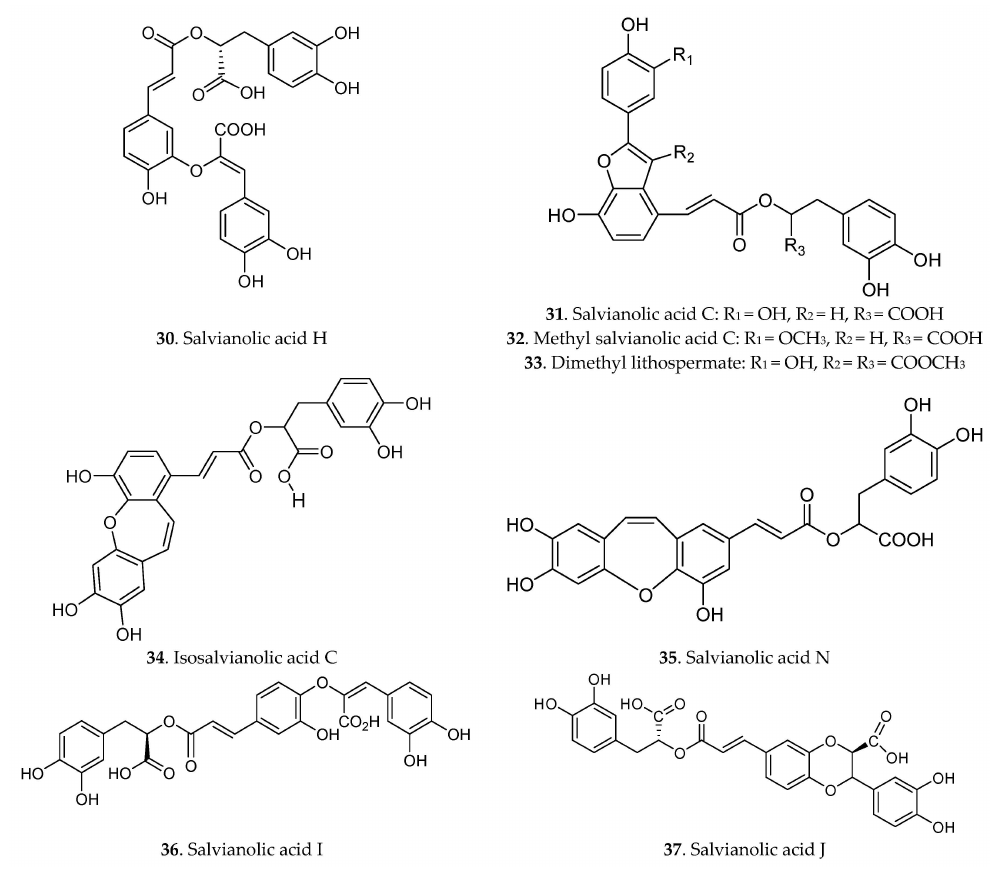
Figure 2. Phenolic acids in Radix Salviae miltiorrhizae